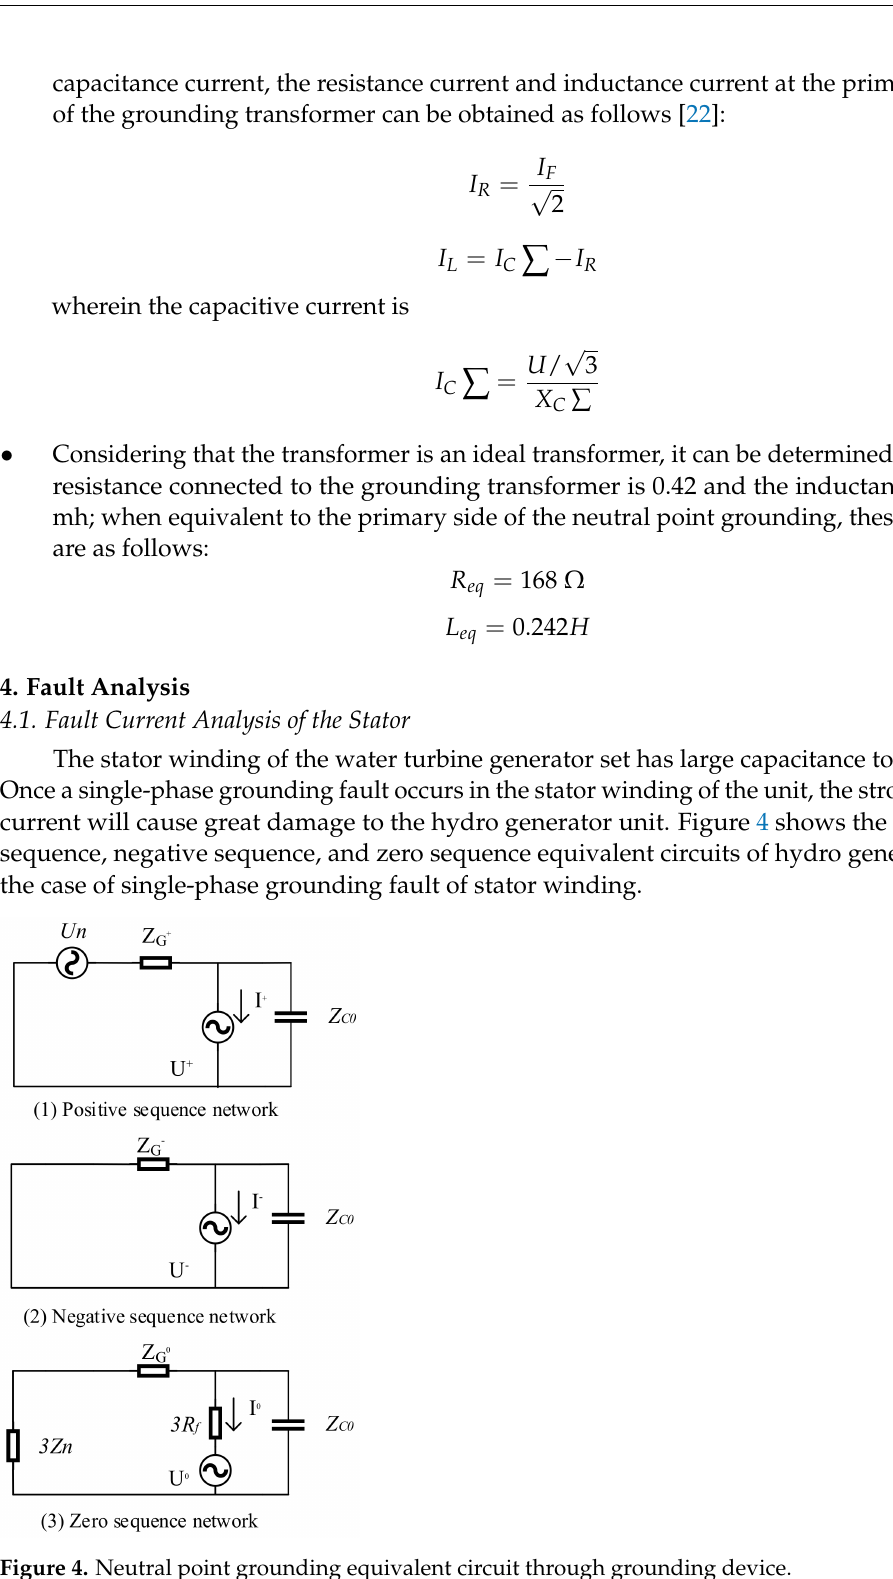
Figure 4. Neutral point grounding equivalent circuit through grounding